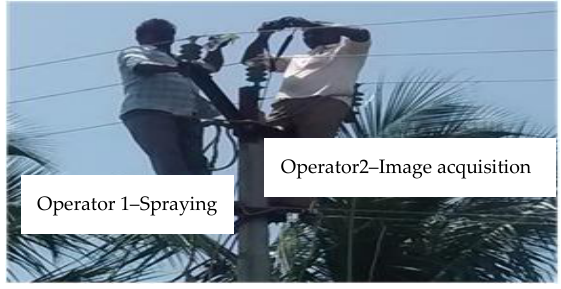
Figure 11. Field test carried out in the test site.